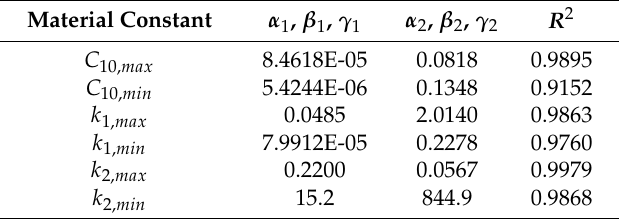
Table 1. Coefficients and R-squared in the correlation between values of material constants and formulae.